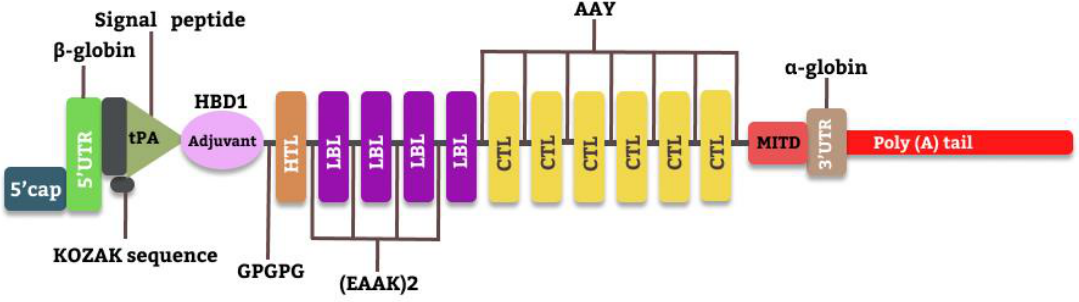
Figure 3. The schematic representation of the mRNA universal construct.